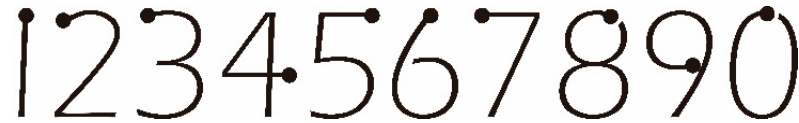
Figure 2. The ten numeric characters used in our study. Dots represent starting points.